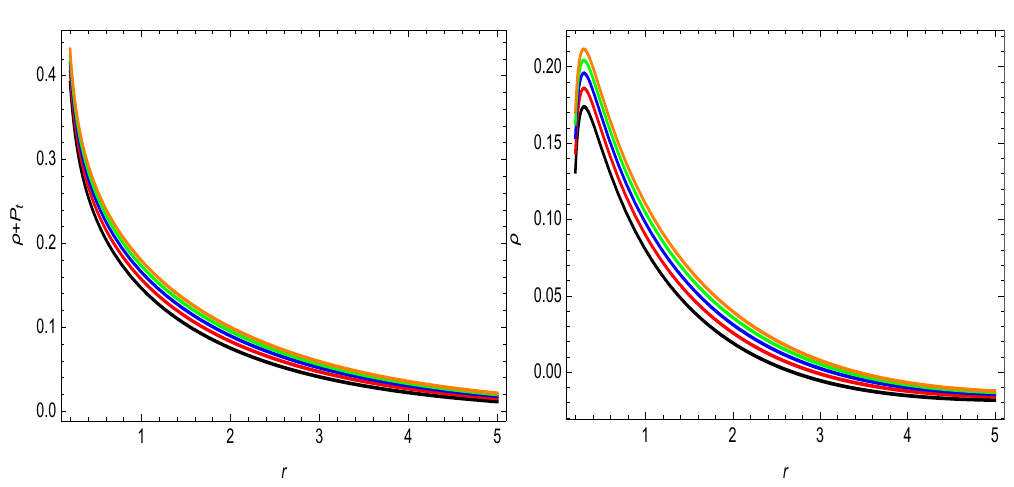
Figure 3. The variational behavior of ρ + P t , and ρ + P r . Here, α = 0.40 ( (cid:70) ), α = 0.50 ( (cid:70) ), α = 0.60 ( (cid:70) ), α = 0.70 ( (cid:70) ), α = 0.80 ( (cid:70) ), and γ =